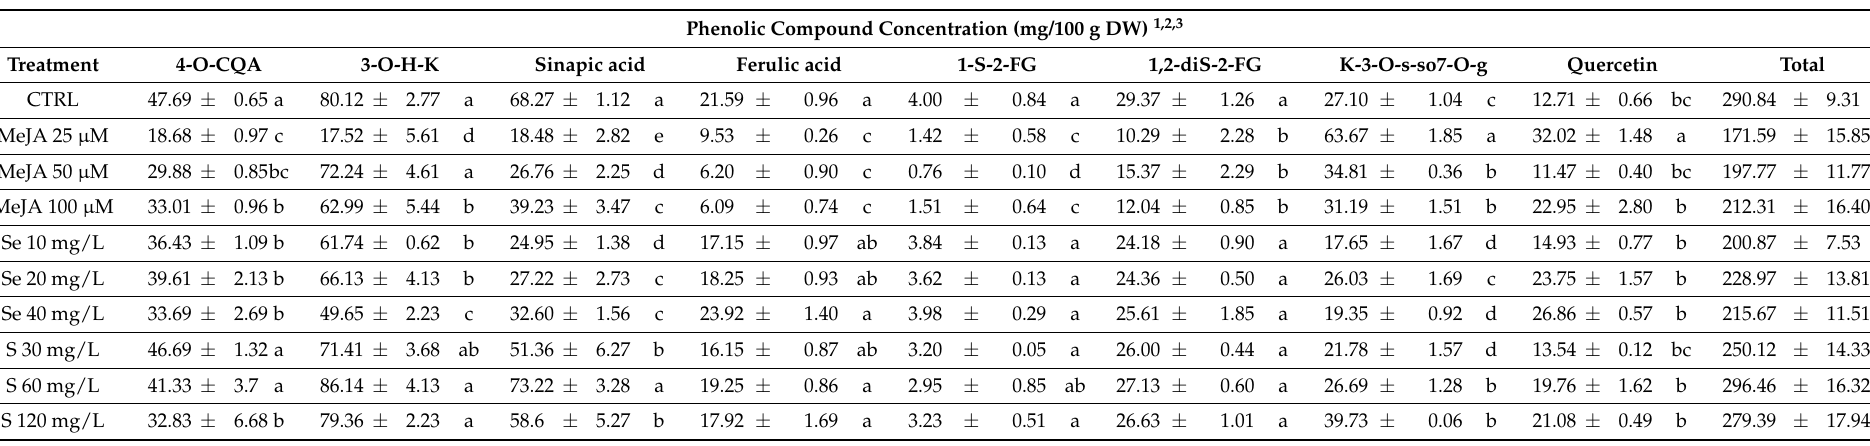
Table 1. Concentration of individual and total phenolic compounds in Red Russian kale sprouts treated with MeJA, Se, and S after 7 d of